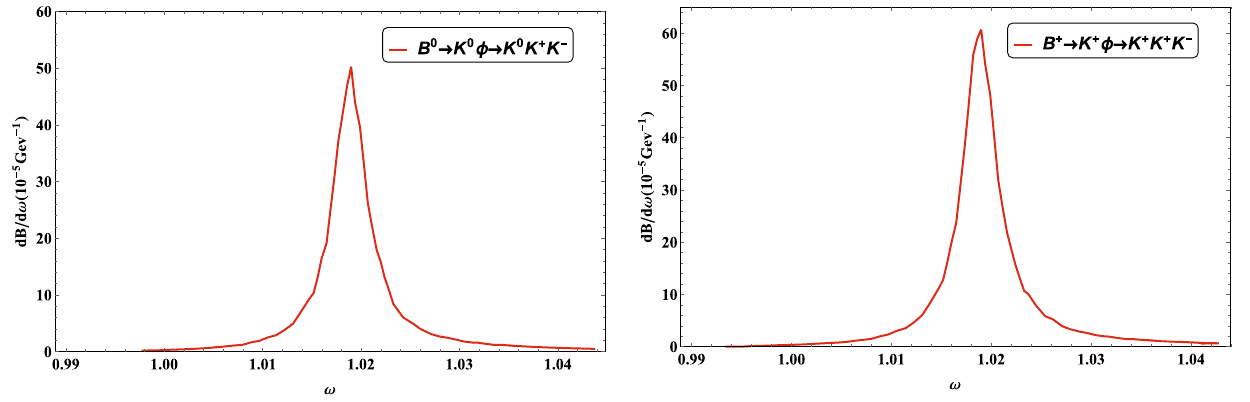
Fig. 2 The ω -dependence of differential branching fractions for the B → K φ → K K K